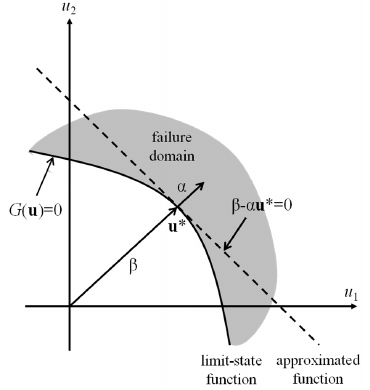
Figure 1. Linear approximation in the first-order reliability method (FORM).